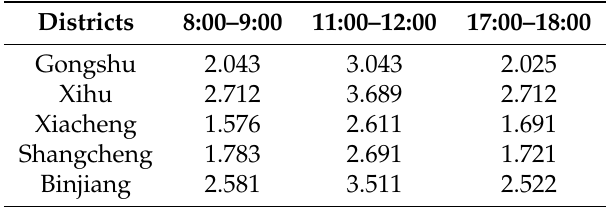
Table 2. Overall performance of pollution detection from